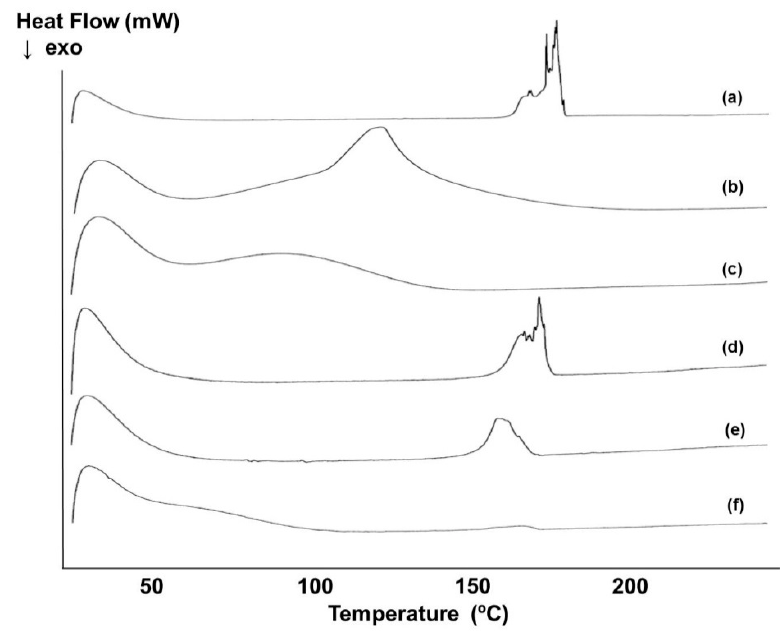
Figure 5. Differential scanning calorimetry (DSC) curves for: ( a ) pure nepafenac, ( b ) pure γ CD, ( c ) pure HP β CD, ( d ) freeze-dried nepafenac and mixture of 15% γ CD/2.5%HP β CD complex, ( e ) freeze-dried of nepafenac/15% γ CD/5%HP β CD complex and ( f ) freeze-dried nepafenac/15% γ CD/8%HP β CD complex. Exo; exothermic.